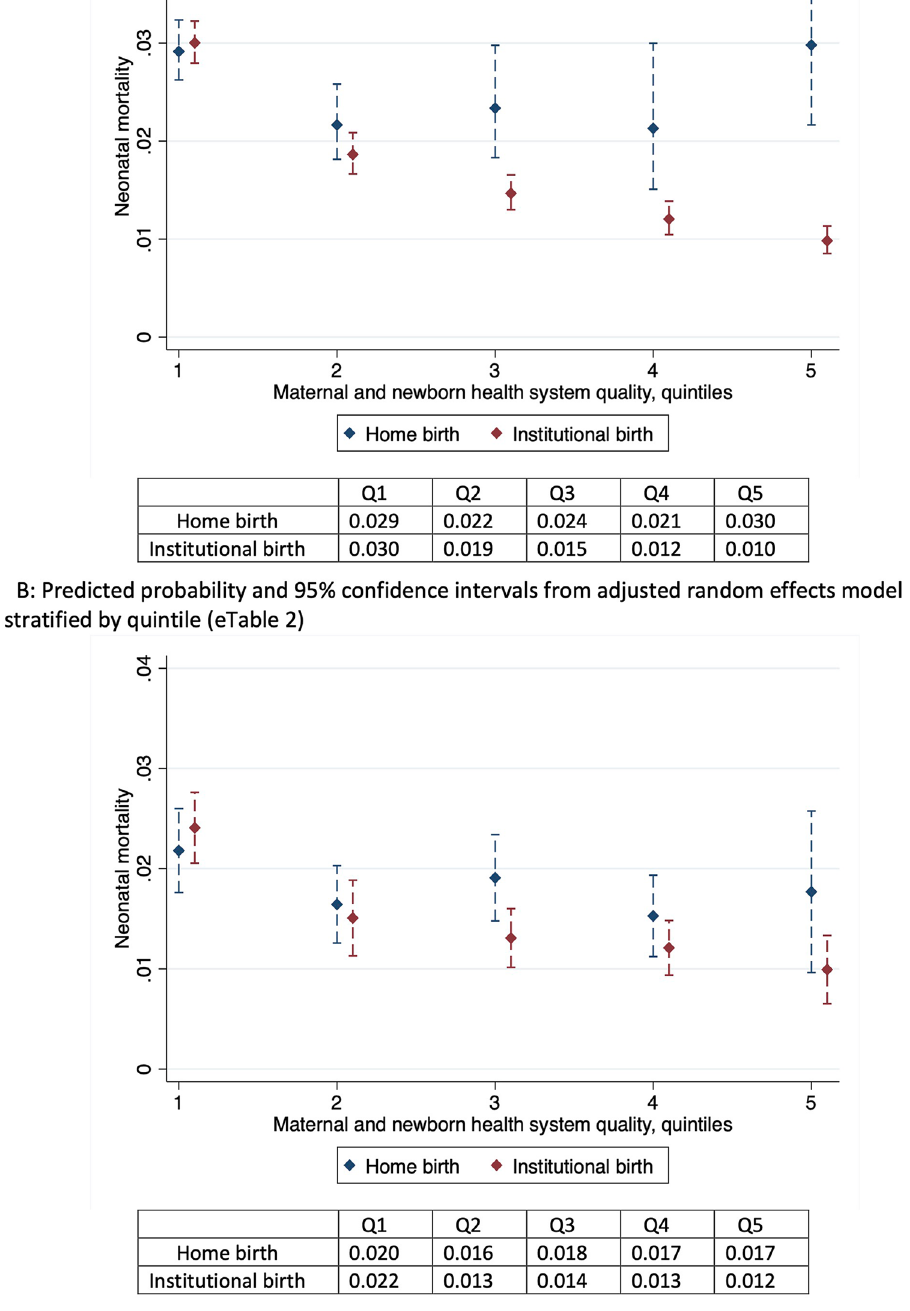
Figure 2. Neonatal mortality by quintile of district-level maternal and newborn health system